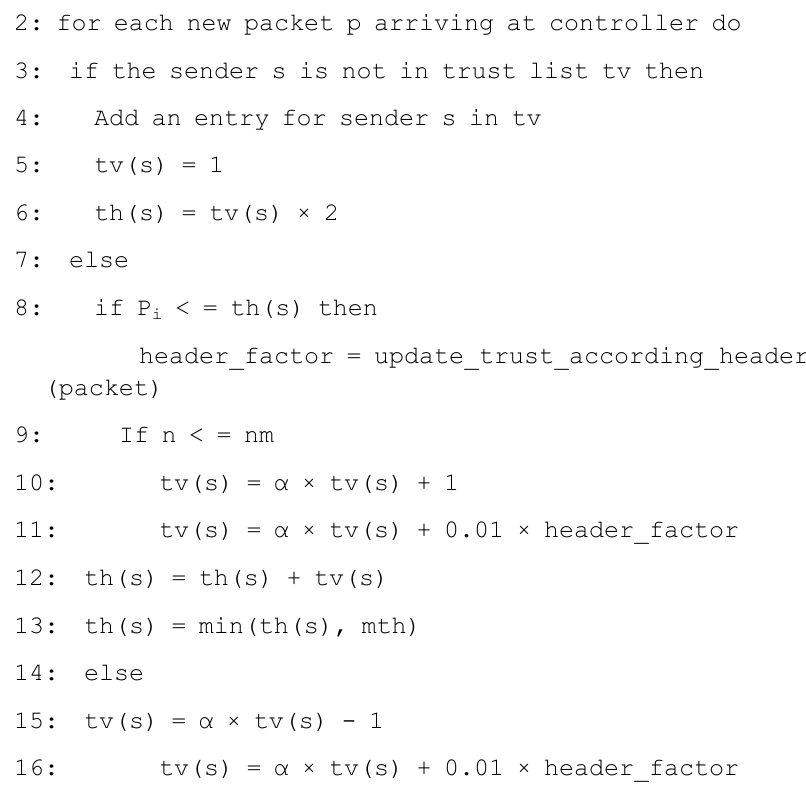
Algorithm 2. Trust management based on header fields’